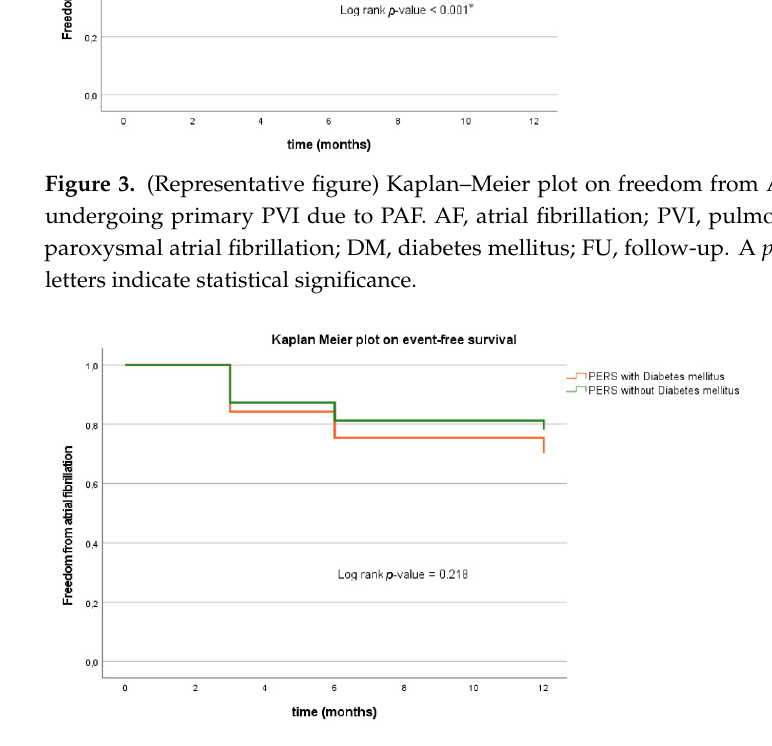
Figure 4. Kaplan–Meier plot on freedom from AF recurrence in patients undergoing primary PVI ablation due to PERS. AF, atrial fibrillation; PVI, pulmonary vein isolation; PERS, persistent atrial fibrillation; DM, diabetes mellitus; FU, follow-up.